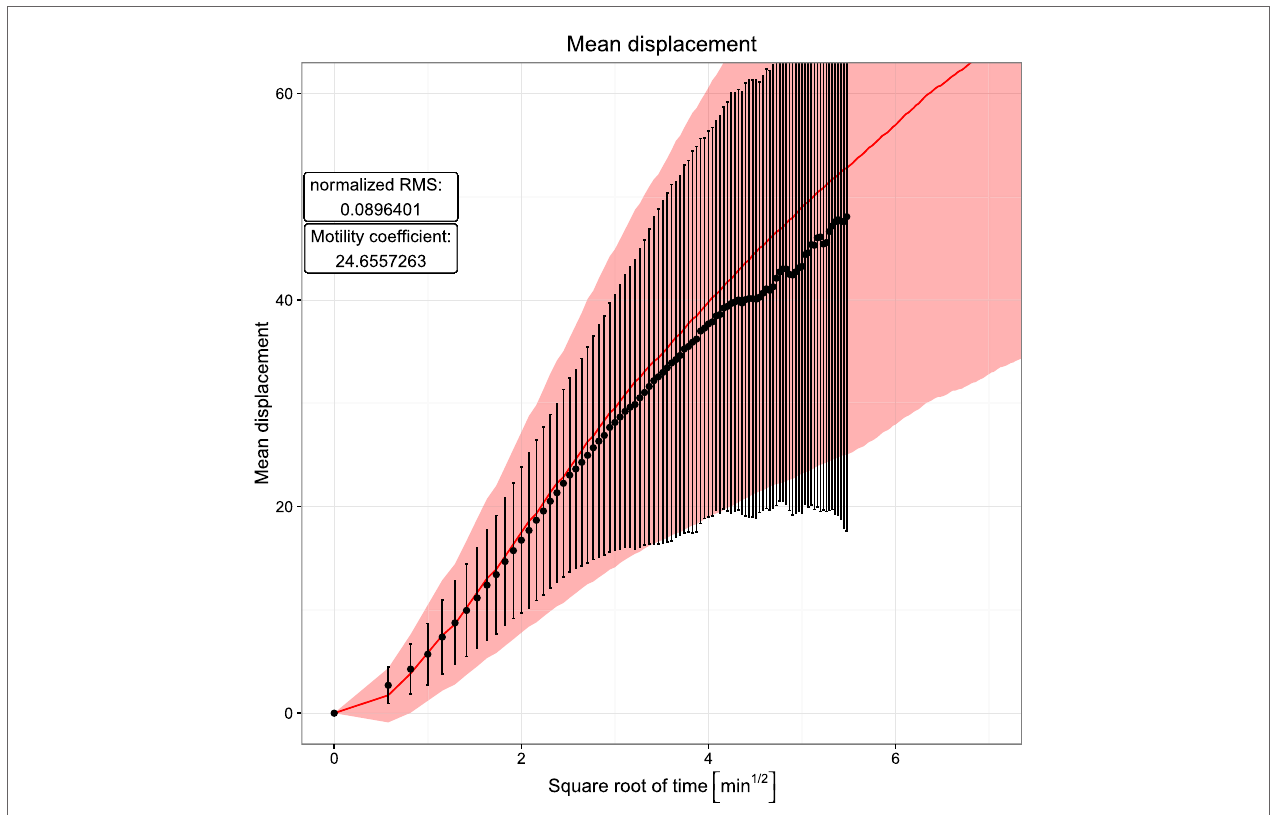
FigUre 2 | Mean displacement versus square root of time . Dots and error bars indicate the mean displacement and SD of tracked cells as measured in experiment (6). The red line and shaded area show mean displacement and SD of tracked cells in 20 simulations. The cell position is tracked every 20 s both in silico and in